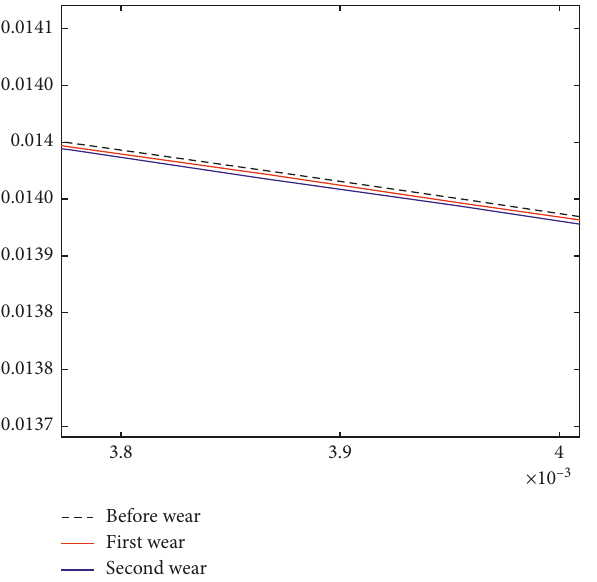
Figure 13: Local enlarged drawing of the bearing surface of joint A